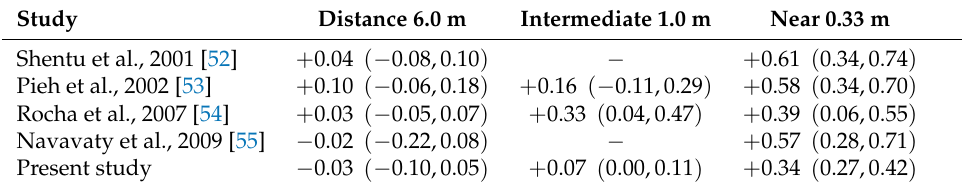
Table 5. Previously published results for (mean and 95% CIs) VA estimation (logMAR) for different viewing distances. The results for the present study are added, with simulated bounds computed from the regression model single prediction 95% CIs as explained in the